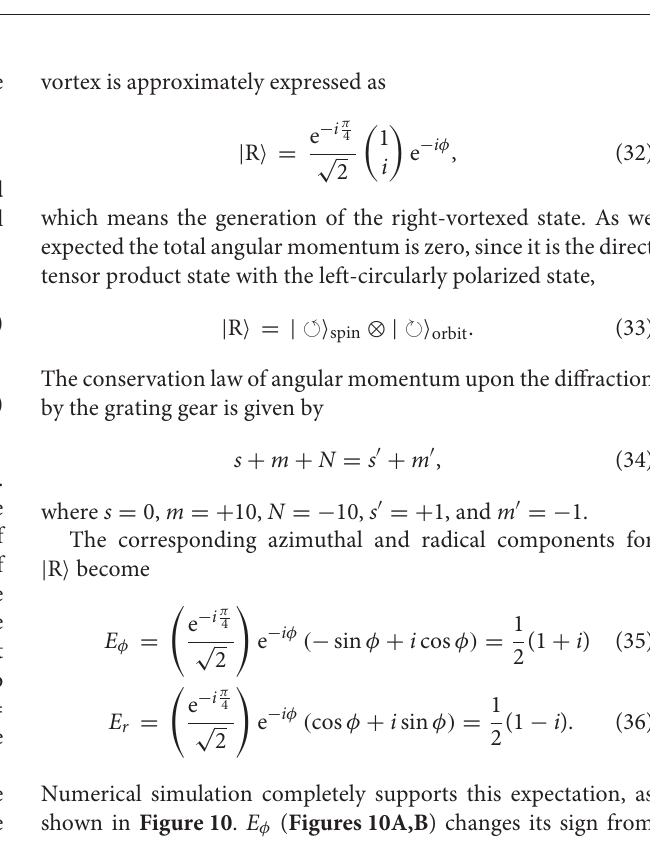
FIGURE 10 | Right vortex generated from the gear of N 10. The input port 2 is used to inject photons to the waveguide, and the mode profile is obtained at = z 1 µ m above the gear. (A) Real part, (B) imaginary part, and (C) intensity of the azimuthal complex electric field ( E φ ). (D) Real part, (E) imaginary part, and = (F) intensity of the radial complex electric field ( E r ). E φ is pointing toward n φ